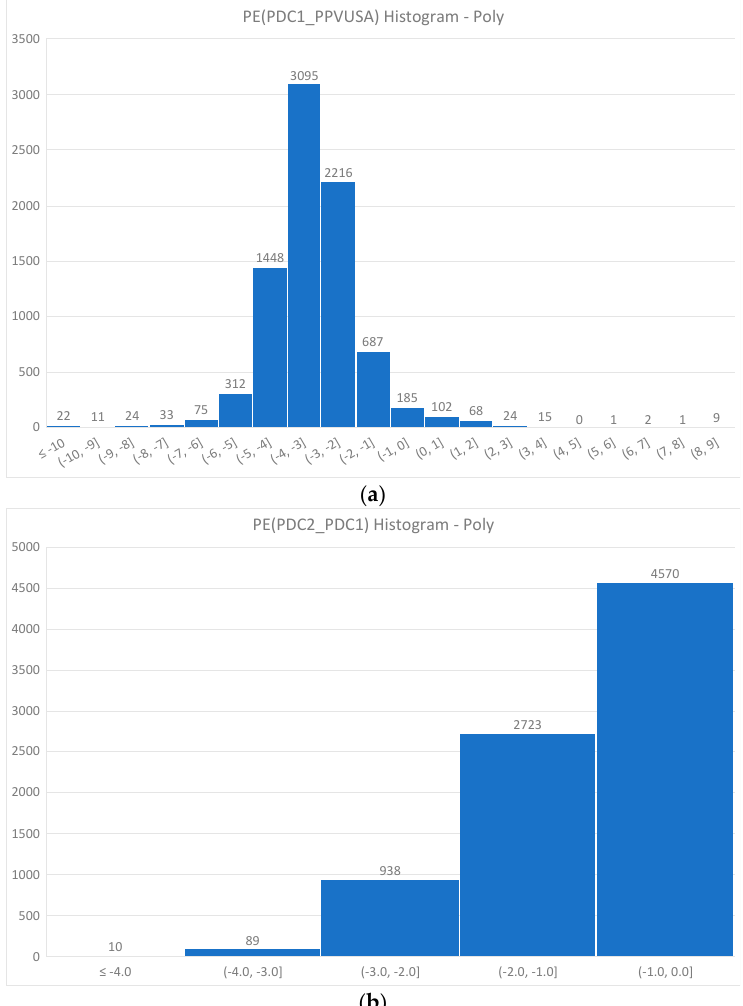
Figure 10. Histograms of the Percentage Error 𝑃𝐸 (cid:2869)(cid:3017)(cid:3023)(cid:3022)(cid:3020)(cid:3002) concerning 𝑃𝐷𝐶 (cid:2869)(cid:3017)(cid:3023)(cid:3020)(cid:3022)(cid:3002) and 𝑃 (cid:3017)(cid:3023)(cid:3022)(cid:3020)(cid:3002) ( a ), and the Percentage Error 𝑃𝐸 (cid:2870)(cid:3017)(cid:3023)(cid:3022)(cid:3020)(cid:3002) concerning 𝑃𝐷𝐶 (cid:2870)(cid:3017)(cid:3023)(cid:3022)(cid:3020)(cid:3002) and 𝑃𝐷𝐶 (cid:2869)(cid:3017)(cid:3023)(cid:3022)(cid:3020)(cid:3002) ( b ); monocrystalline modules.